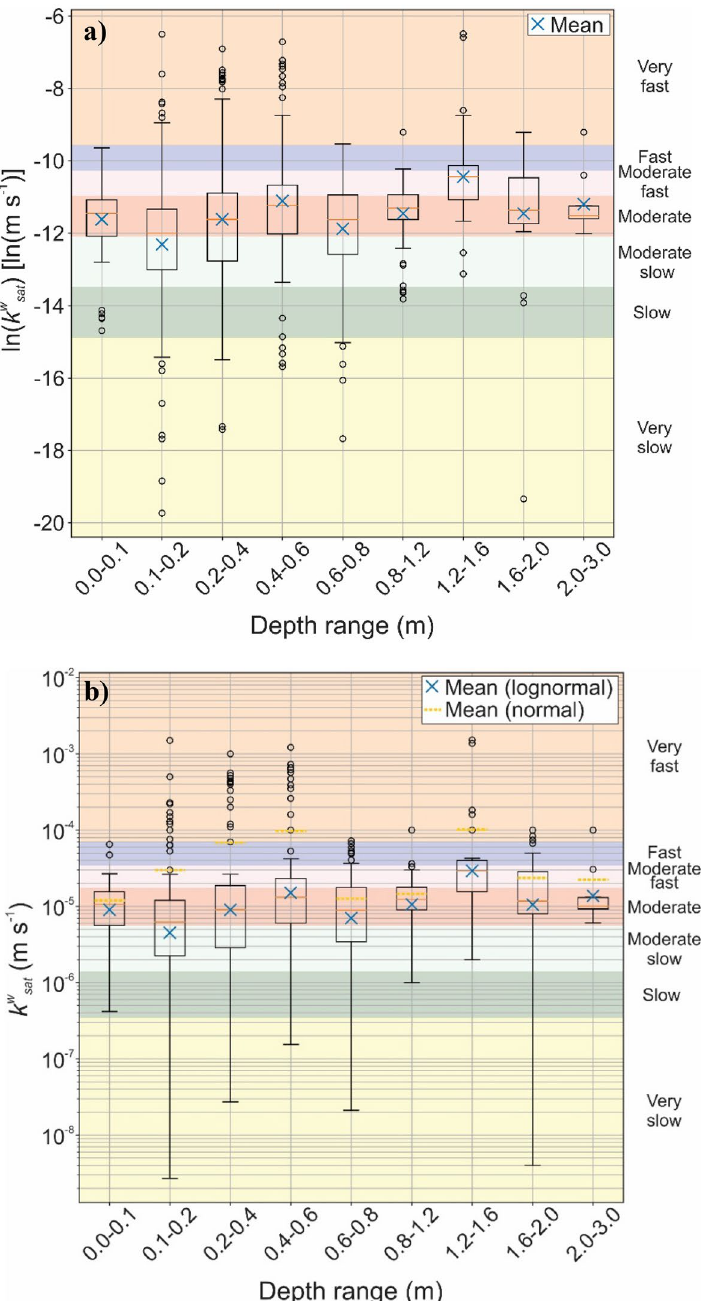
Figure 6. Distribution of saturated hydraulic conductivity of lateritic soils by depth range, classified according to Table 1: ( a ) ln k sat ; ( b ) k sat